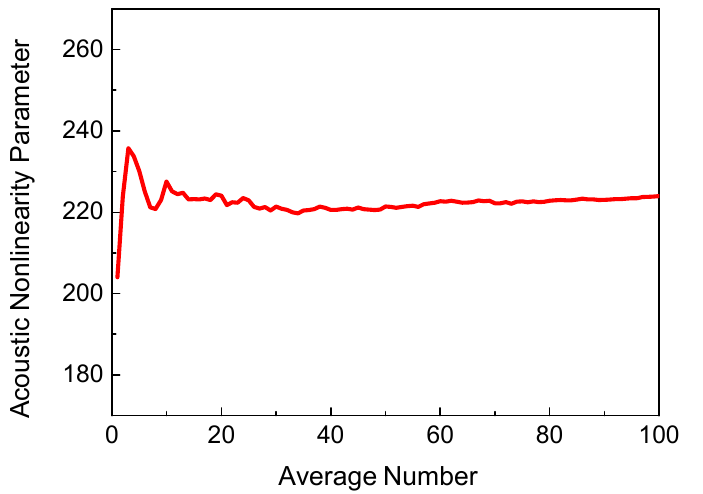
Figure 3. Acoustic nonlinearity parameter (ANP) versus average number of FEM models ( c = 0.009375, f R = 6 MHz, µ = 0, L 1 = 40 mm, L 2 = 4 mm, L 3 = 36 mm).